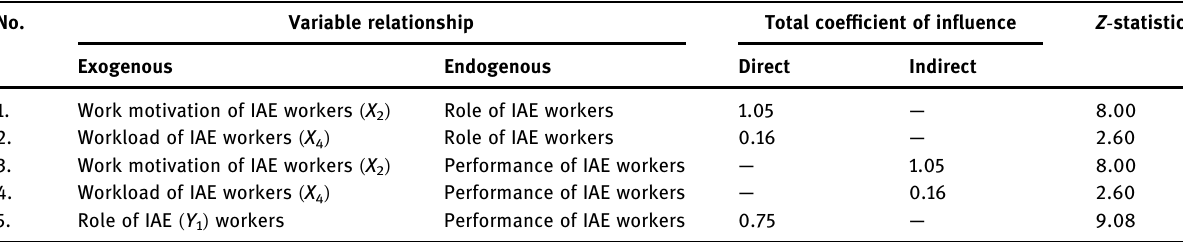
Table 8: The variable relationship among variables